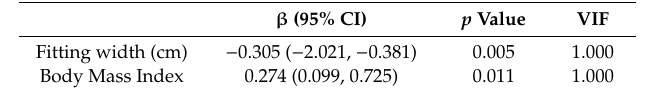
Table 4. Relationship between PSS (peak shear stress) and, lower extremity joint angles and characteristics in the fifth metatarsal